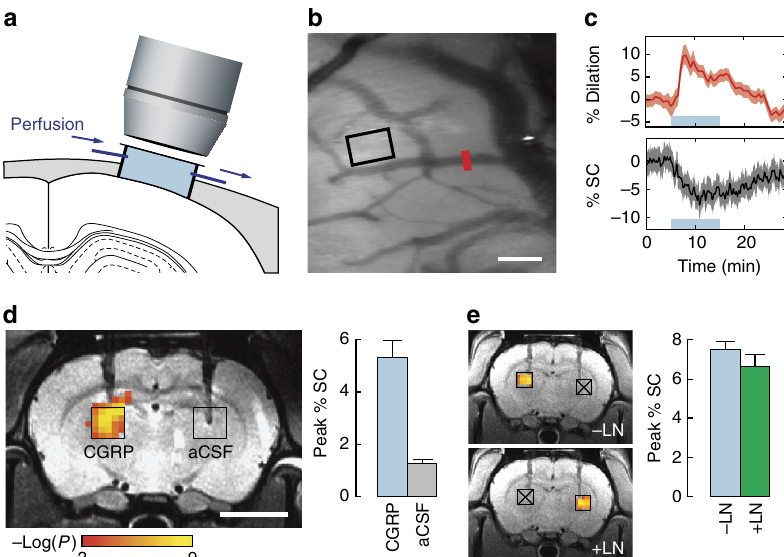
Figure 2 | Imaging artificial haemodynamic responses induced by CGRP probes in vivo . ( a ) Direct effects of superficially perfused CGRP on cerebral vasculature are assessed by optical reflectance imaging of exposed cortex. ( b ) Cortical image of a single rat, revealing discrete blood vessels (dark) and parenchymal tissue (light background). Scale bar, 100 m m. ( c ) Time course of average CGRP-induced haemodynamic changes in five animals; shading denotes standard errors as a function of time. The CGRP infusion period is denoted by the blue shaded lines. Top panel shows changes in the diameter of macroscopic vessels as indicated by the red bar in b . Bottom panel shows mean optical signal changes in parenchymal regions as denoted by the black rectangle in b ; downward deflection of the curve during CGRP administration is consistent with increasing parenchymal cerebral blood volume, which darkens images. ( d ) MRI changes observed in conjunction with deep intracranial injection of CGRP (100nM) or vehicle only (aCSF), both at 0.1 m lmin (cid:2) 1 . for 10min into the parenchyma of the thalamus. Coloured voxels overlaid on a greyscale anatomical image (left) indicate the correlation strength of observed signal changes with the injection period. Bar graph (right) indicates peak signal changes observed upon injection of CGRP or aCSF, each averaged over corresponding injection regions in multiple animals (black boxes at left, n ¼ 6). Scale bar, 5mm. ( e ) Dissociation of CGRP-induced artificial haemodynamic signals from nitric oxide-mediated signalling. Left, haemodynamic responses observed by imaging upon unilateral CGRP injection into the left thalamus, before L-NAME delivery (-LN, top), or into the right thalamus, after 50mgkg (cid:2) 1 intravenous L-NAME infusion ( þ LN, bottom). Sites denoted by crossed out boxes did not receive CGRP injections under the conditions labelled. Right, comparison of peak percent signal changes observed in regions as identified on the left, without and with L-NAME and showing no significant difference. Error bars throughout this figure denote s.e.m. values ( n ¼